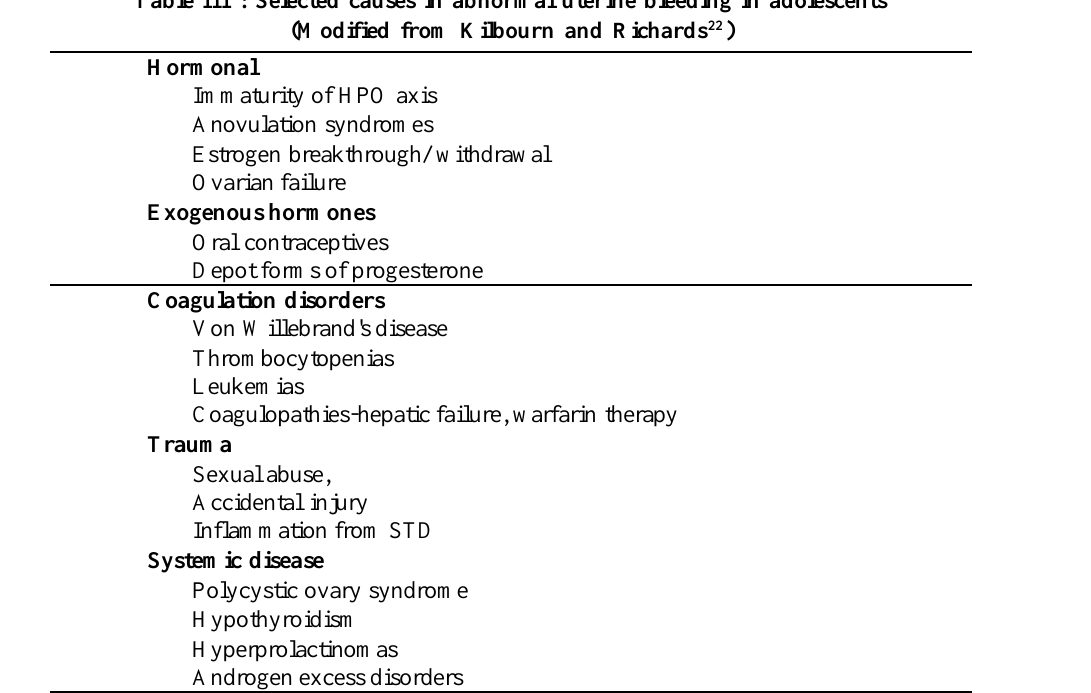
Table III : Selected causes in abnormal uterine bleeding in